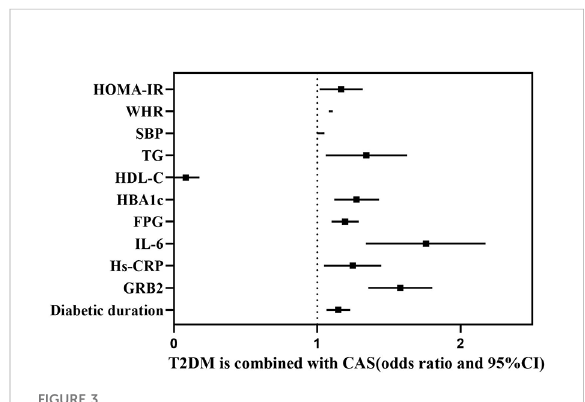
FIGURE 3 Forest plot showing the in fl uencing factors associated with whether T2DM is combined with